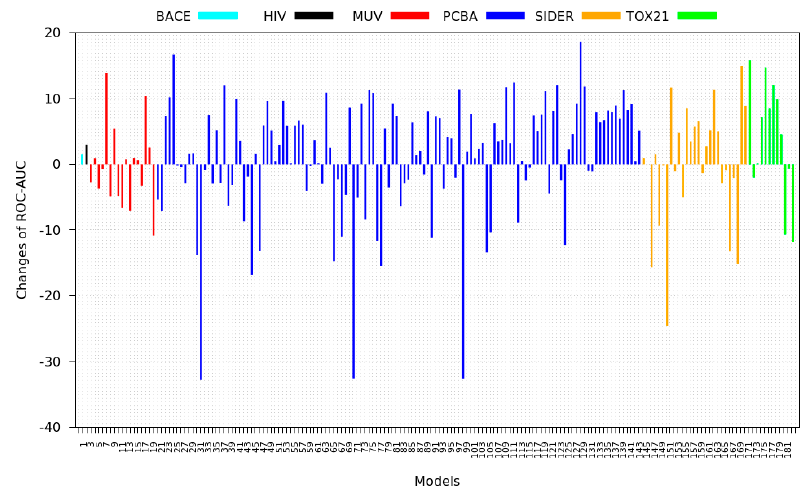
Figure 3. The change in performance and the area under receiver operating curve (ROC-AUC) of model after transfer learning.